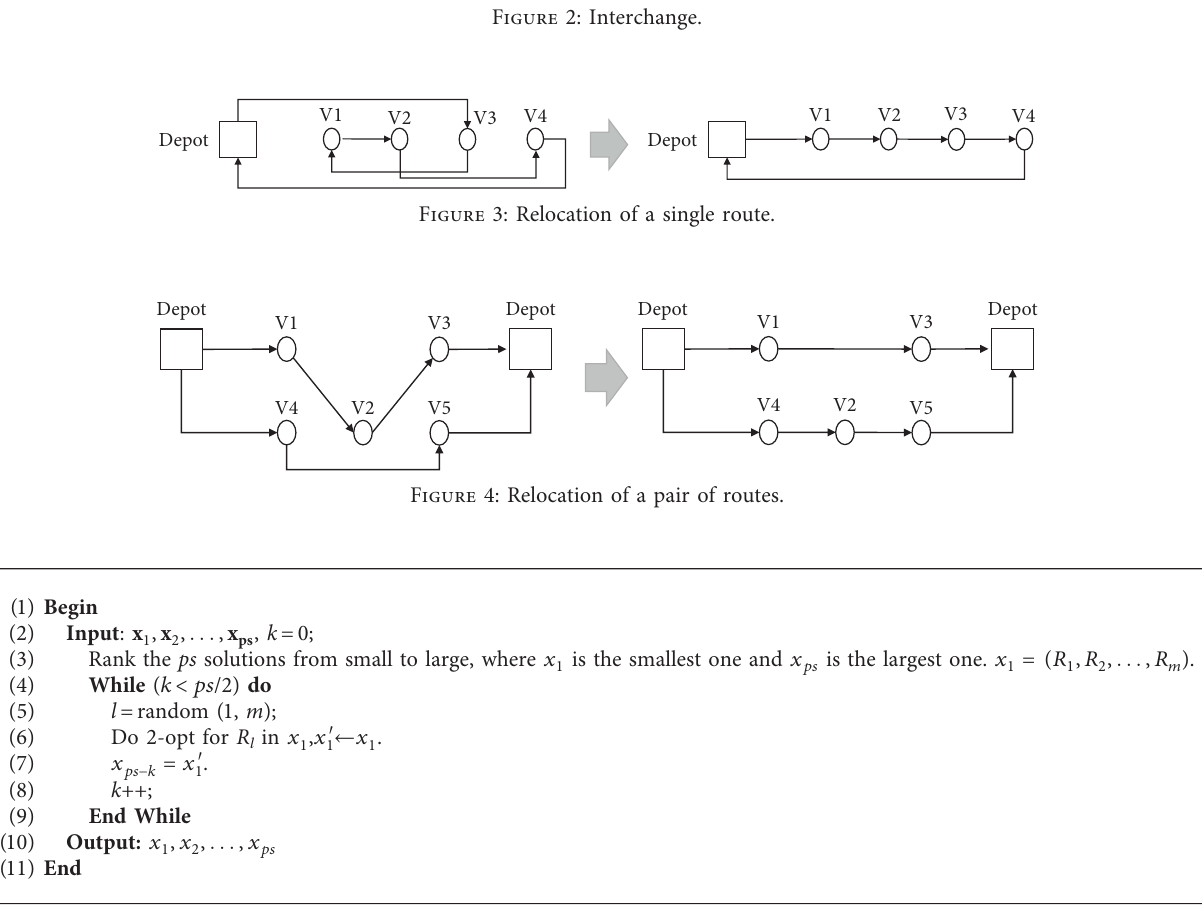
Figure 2: Interchange.